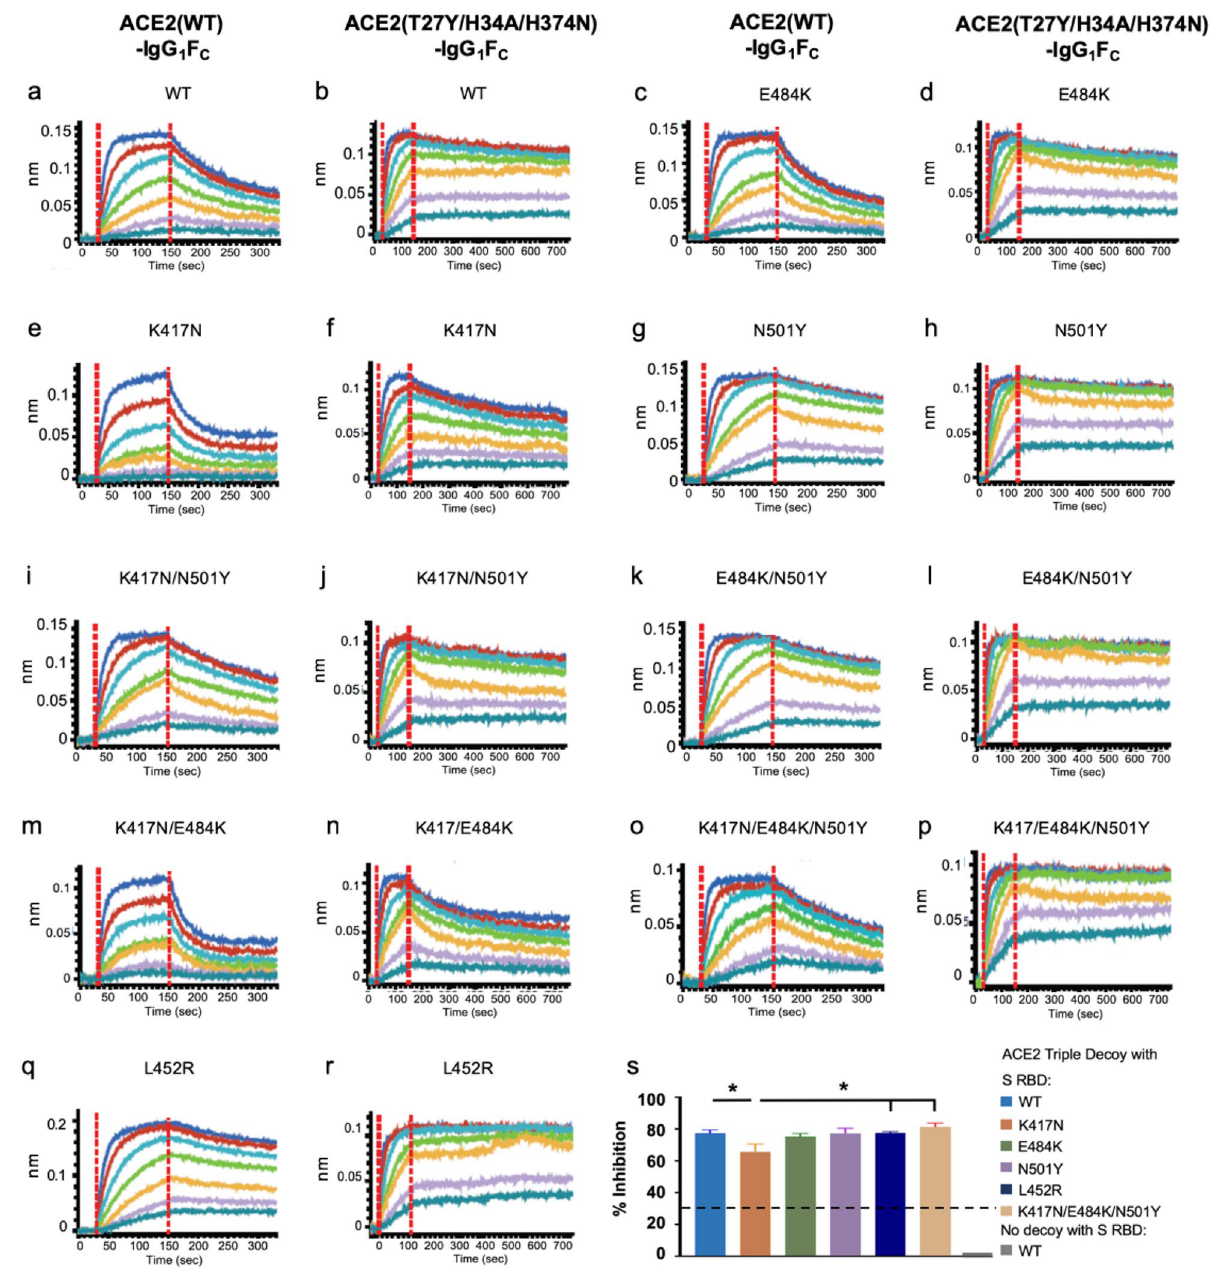
Figure 3. BLI of ACE2(WT) or Triple Decoy for mutated RBD and inhibition in the neutralization assay. ( a – r ) BLI of WT or Triple Decoy ACE2 to WT or mutated S RBD are shown side-by-side. ( s ) The percent inhibition of RBD binding to ACE2 in the surrogate neutralization assay is shown for the ACE2 Triple Decoy with S RBD WT and listed variants. RBD concentrations were 25 μg/mL. The negative control is no decoy. Inhibition of ≥ 30% (dashed line) correlates with neutralization of the virus. Data graphed as mean with SEM. Statistics: one- way ANOVA and Tukey’s post-hoc analysis comparing Triple Decoy binding to RBD WT/variants. For RBD K417N vs WT, p = 0.0495; vs L452R, p = 0.0451; and vs E484K/K417N/N501Y, p =